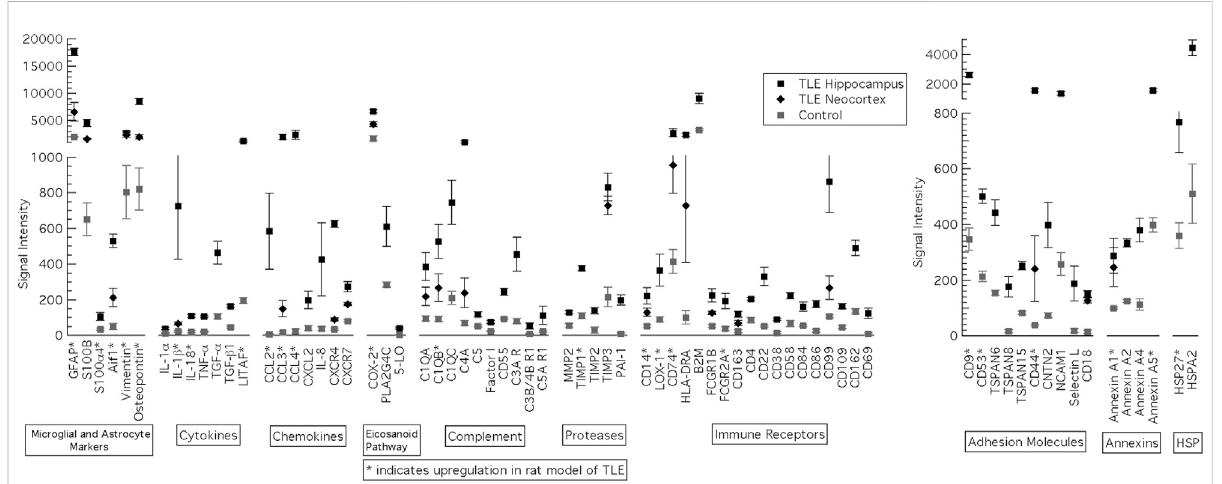
FIGURE 4 Genes signi fi cantly upregulated in the hippocampus and lateral temporal neocortex of patients with MTLE. In fl ammatory genes were classi fi ed into10groups:microgliaandastrocytemarkers,Cytokines,Chemokines,EicsanoidPathway,Complement,Proteases,ImmuneReceptors,Adhesion Molecules, Annexinsand heatshockproteins(HSP). * GenesalsoupregulatedintheratKA modelofMTLE.Reproducedwiththepermissionfromthe author (SK), J Child Neurology 2018. vol 33 (1) 64 –